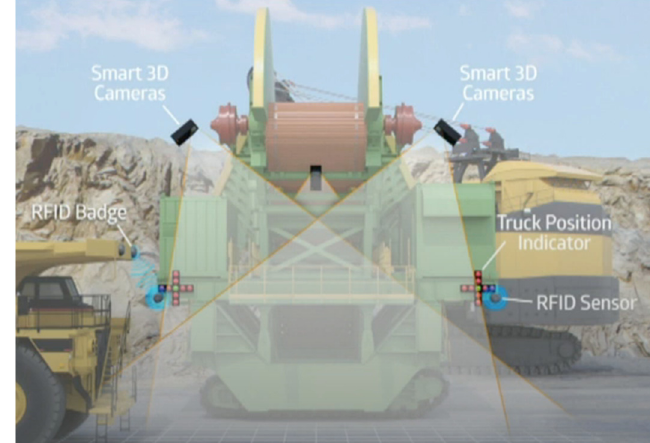
Figure 9. Camera system [23].